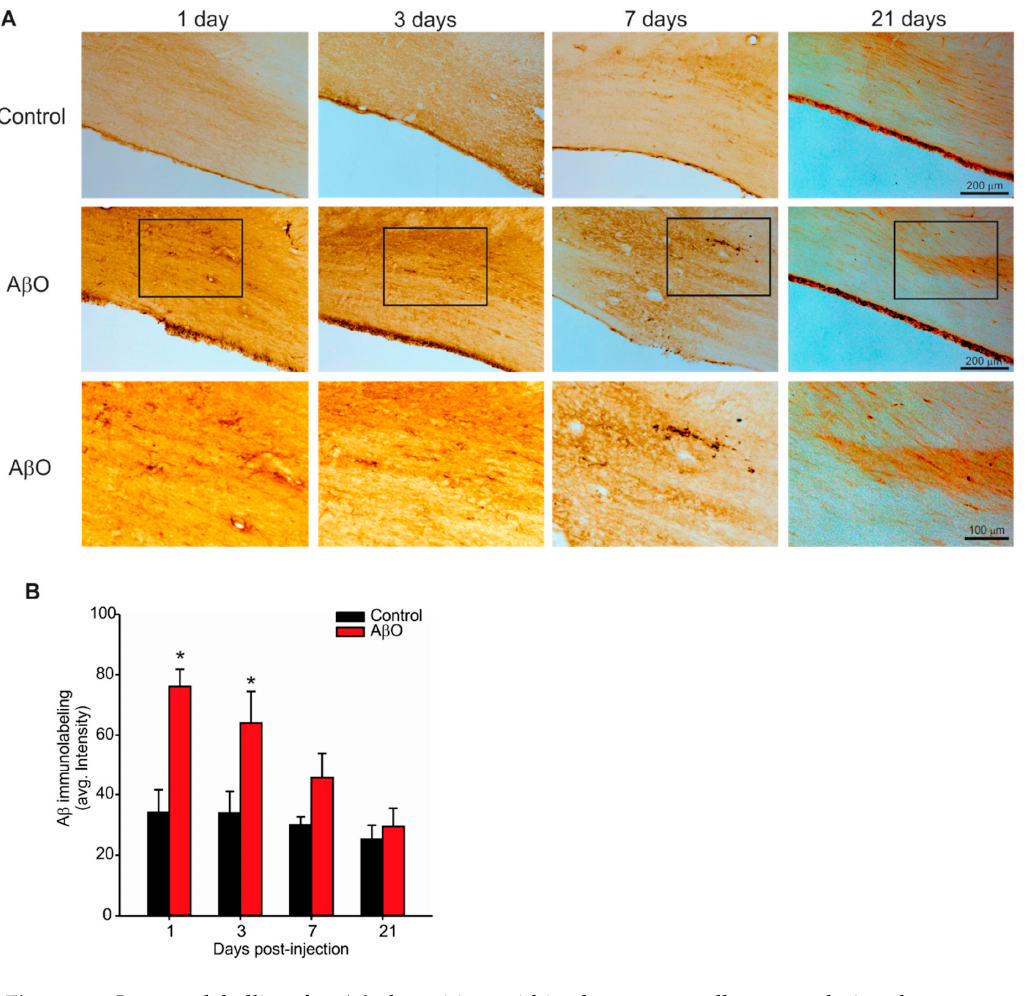
Figure 2. Immunolabelling for A β deposition within the corpus callosum and cingulate gyrus. Paraformaldehyde perfused rat brains were sectioned at 30 µm and stained with the A β 4G8 antibody with an epitope against the 17–24 amino acid sequence of the A β peptide. ( A ) Photomicrographs of the corpus callosum and cingulate gyrus in coronal rat brain sections from A β O-injected and PBS-injected (control) rats 1, 3, 7 and 21 days post-injection. Bottom panels are higher magnification images of the panels immediately above (indicated by the box). Scale bars are 200 or 100 µm as indicated; ( B ) quantification using optical densitometry from three adjacent tissue sections per animal. A β O-injected rats had significantly more A β labelling in the corpus callosum and cingulate gyrus compared to controls at days 1 and 3 post-injection. Data presented as group means ± SEM. * indicates statistical significance between A β O-injected and control rats using 2-way ANOVA followed by Tukey’s post hoc analysis, p < 0.05, n = 5 for each experimental group.